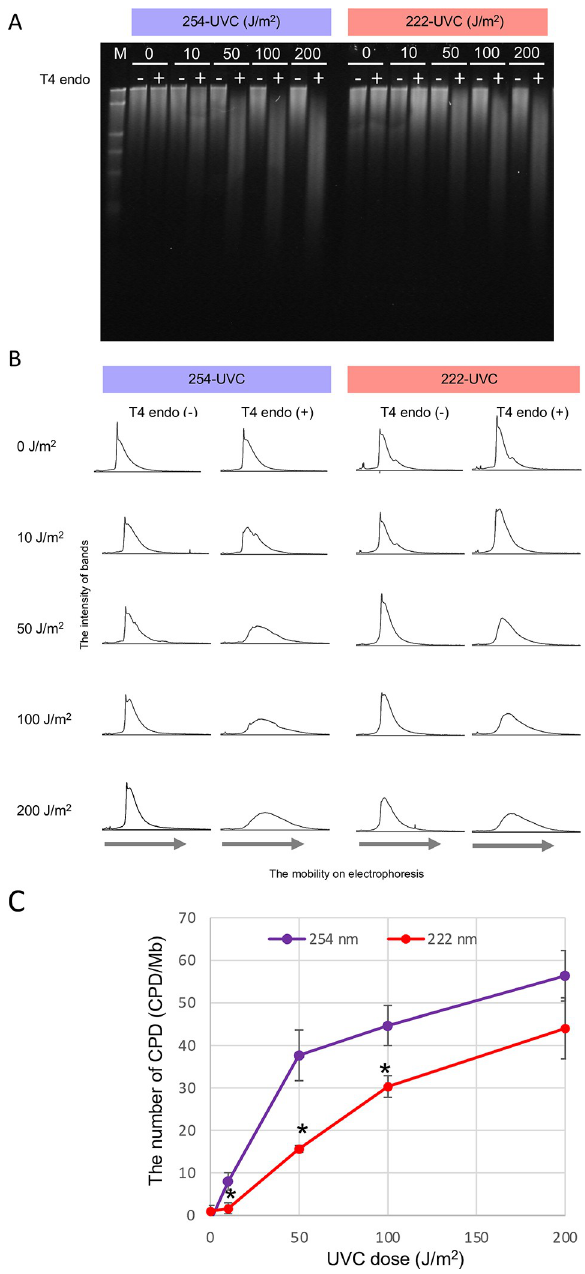
Fig 1. Frequency of CPDs induced by UVC irradiation on lambda DNA. (A) Detection of CPD levels on lambda DNA. Lambda DNA was irradiated by 254- or 222-UVC and the DNA was incubated with (+) or without (-) T4 endonuclease. DNA was analyzed in an alkaline gel. M, size marker (lambda- Hin d III cut). (B) Representation of DNA bands in the form of peaks. (C) The frequency of CPDs is calculated by the frequency of CPDs untreated with T4 endonuclease has been subtracted from the frequency of CPD treated with the enzyme. The purple and red lines indicate DNA damage frequency induced by 254-UVC and by 222-UVC, respectively. Error bars indicate the SE of three independent experiments. � P < 0.05 versus 254-UVC (one-tailed Student’s test).